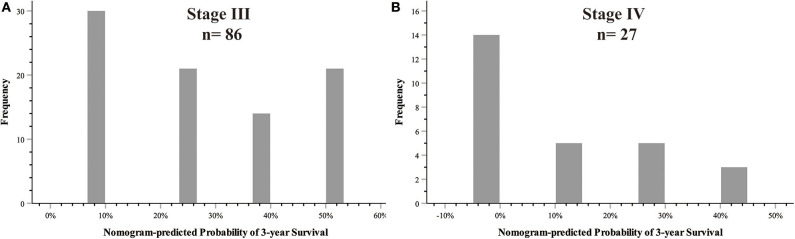
Heterogeneities predicted by nomogram in the AJCC stage. (A) AJCC TNM stage III; (B) AJCC TNM stage IV.